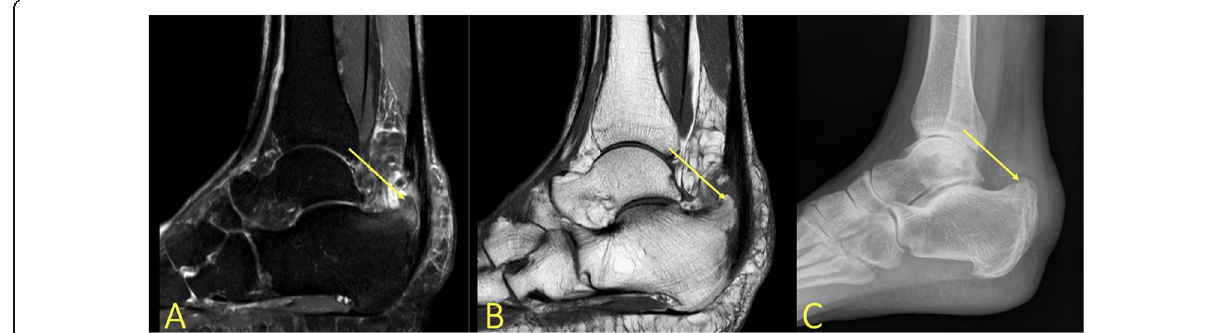
Fig. 11 A 62-year-old female with recurring symptoms after previous surgery for a Haglund deformity. MRI and radiography showed a Haglund deformity (arrow) with bone marrow edema again visible on MRI